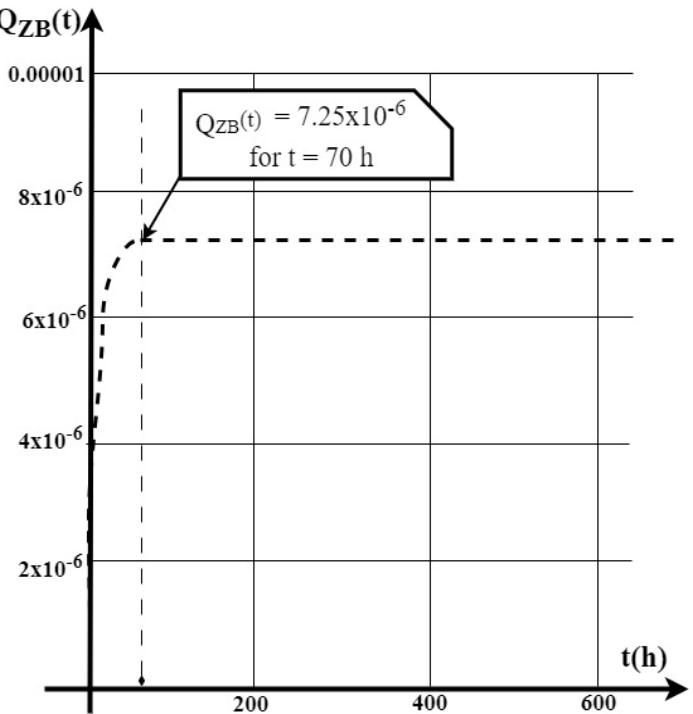
Figure 8. Waveform of the probability function Q ZB ( t ) related to an electronic security system staying in a state of safety hazard.